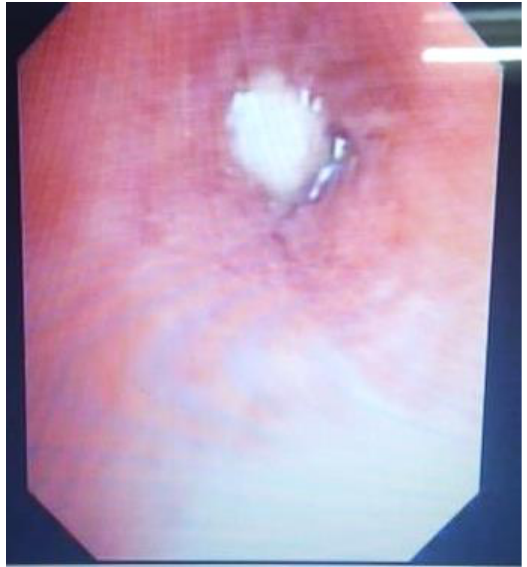
Figure 3. Endobronchial image showing right middle lobe